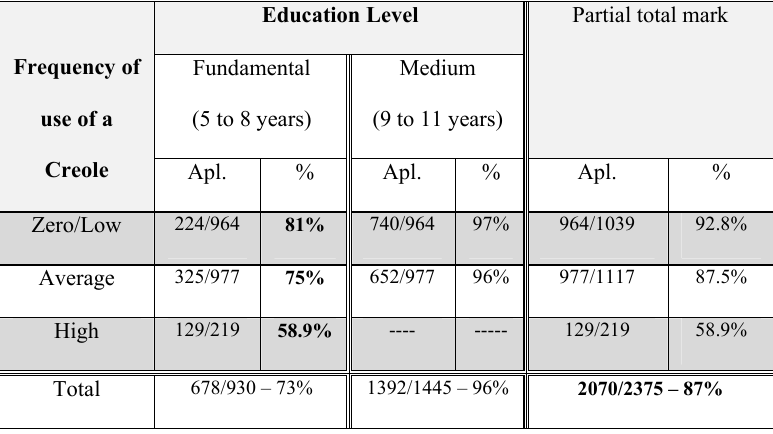
Table XV. Crossing of frequency of use of a Creole and Education level – sample ST(2). Application: number mark presence within the NP Education